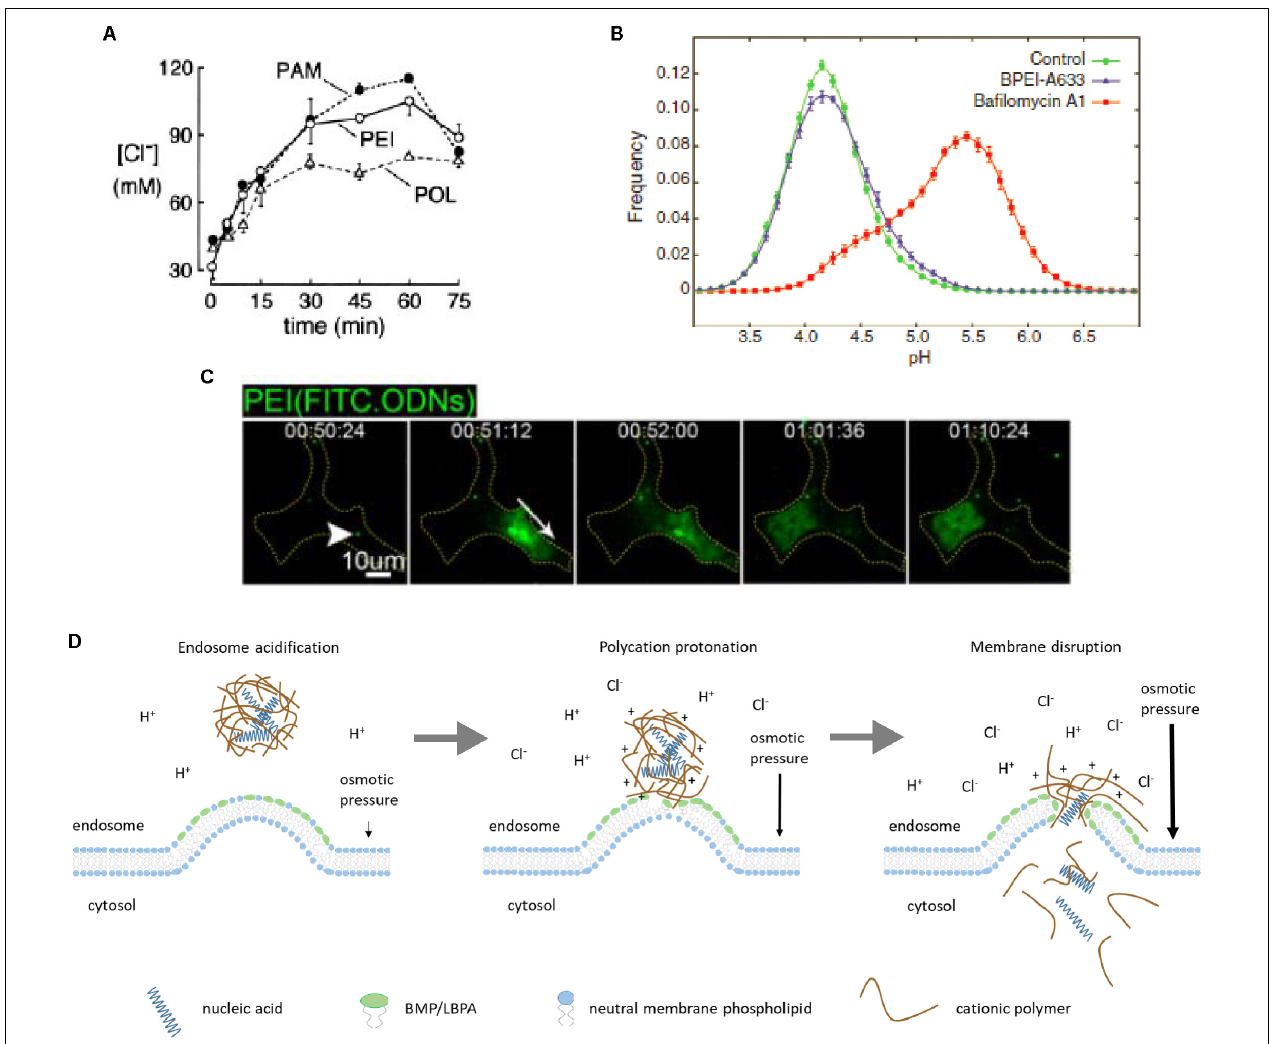
FIGURE 3 | Polyplex endosomal escape. Accumulation of chloride in endosomal vesicles upon cellular uptake of polyamidoamine (PAM), polyethylenimine (PEI), and polylysine (POL) reflects higher buffering capacity of PAM and PEI (A) . Lack of acidic endosomal pH increase in vesicles containing branched PEI (BPEI), compared to bafilomycin A-treated cells, contradicts the “proton sponge” hypothesis (B) . Released polyplex-formulated genetic cargo (FITC-labeled oligodeoxyribonucleotides, ODNs) from an endosome in HeLa cells spreads in a single direction (white arrow) (C) . Proposed mechanism of endosomal escape of polyplex-formulated nucleic acids driven by osmotic pressure and local permeabilization of endosomal membrane due to electrostatic interactions between polycation and anionic phospholipids like BMP/LBPA (D) . Figure adapted with permission from: (A) (Sonawane et al., 2003), ASBMB; (B) (Benjaminsen et al., 2013), Elsevier; (C) (ur Rehman et al., 2013), copyright (2013) American Chemical